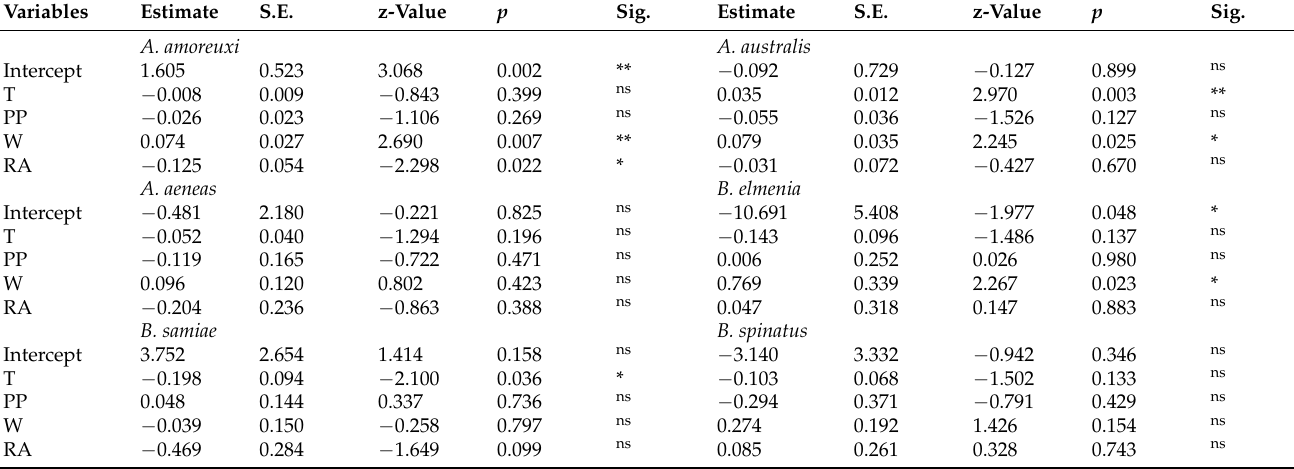
Table 2. GLMM testing effects of climate on variations of scorpion species abundances in the Sahara Desert of Algeria.